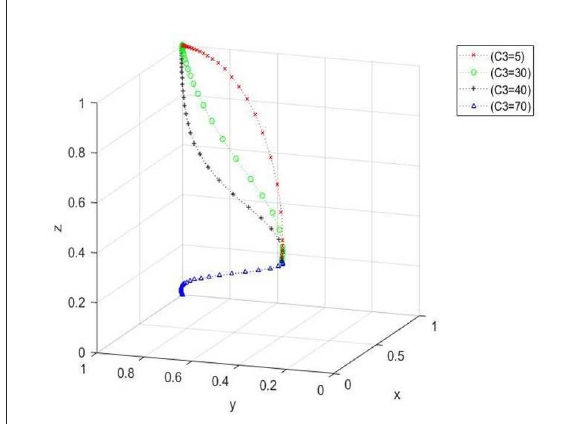
FIGURE5 Spatial diagram of the impact of changes in the cost of purchasing green agricultural materials on the evolutionary path of